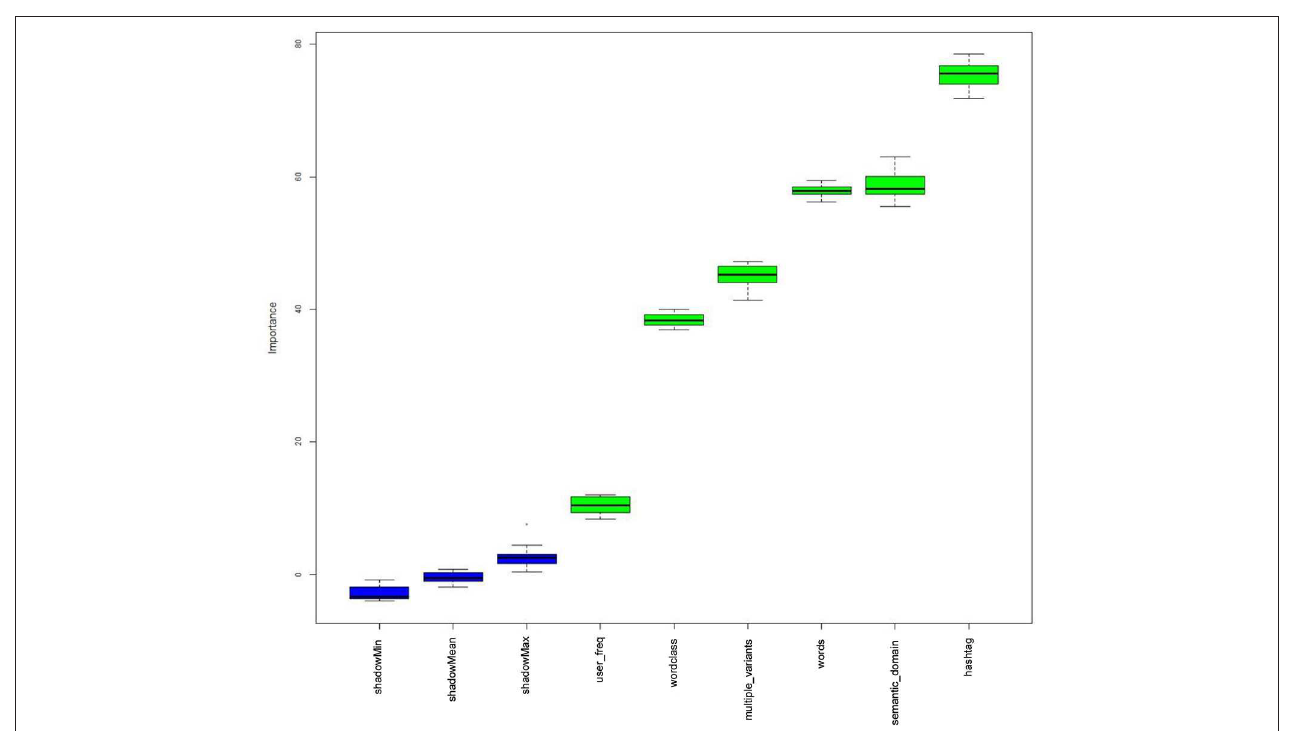
FIGURE 9 | Boruta plot showing the factors which are deemed to be relevant to half-life